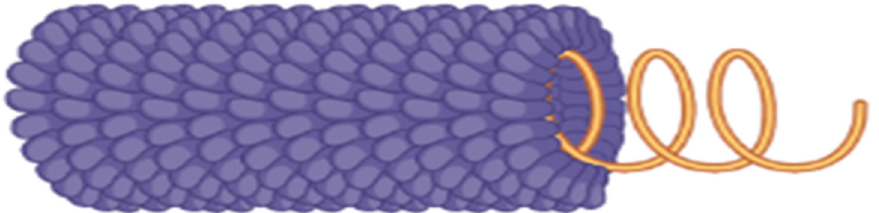
Figure 2. Structural diagram of a TMV particle. Protein subunits are shown in purple while the ssRNA is shown in orange. Source: Image created in Biorender.